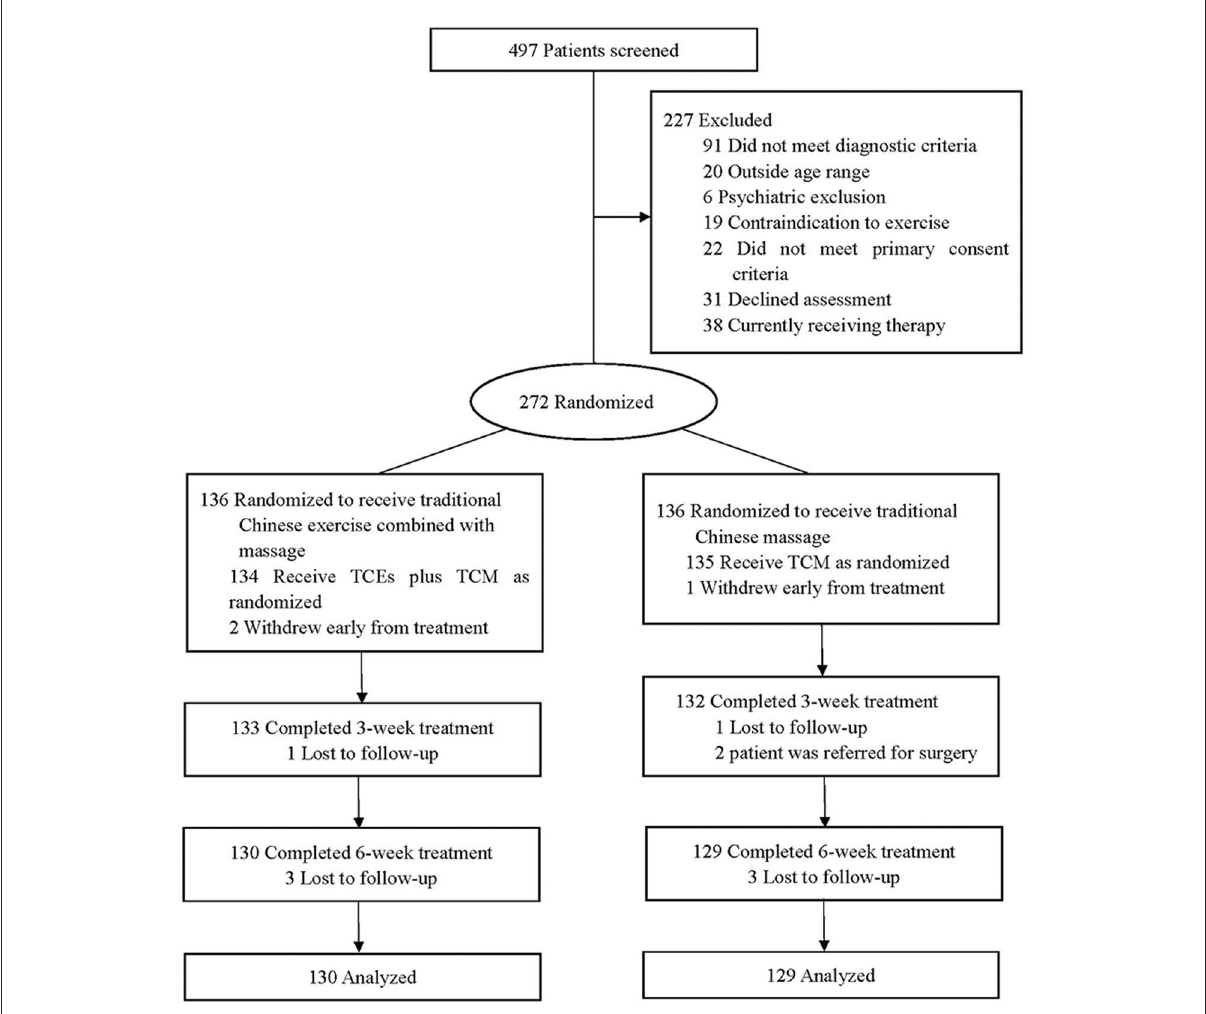
FIGURE3 Flow chart of the study